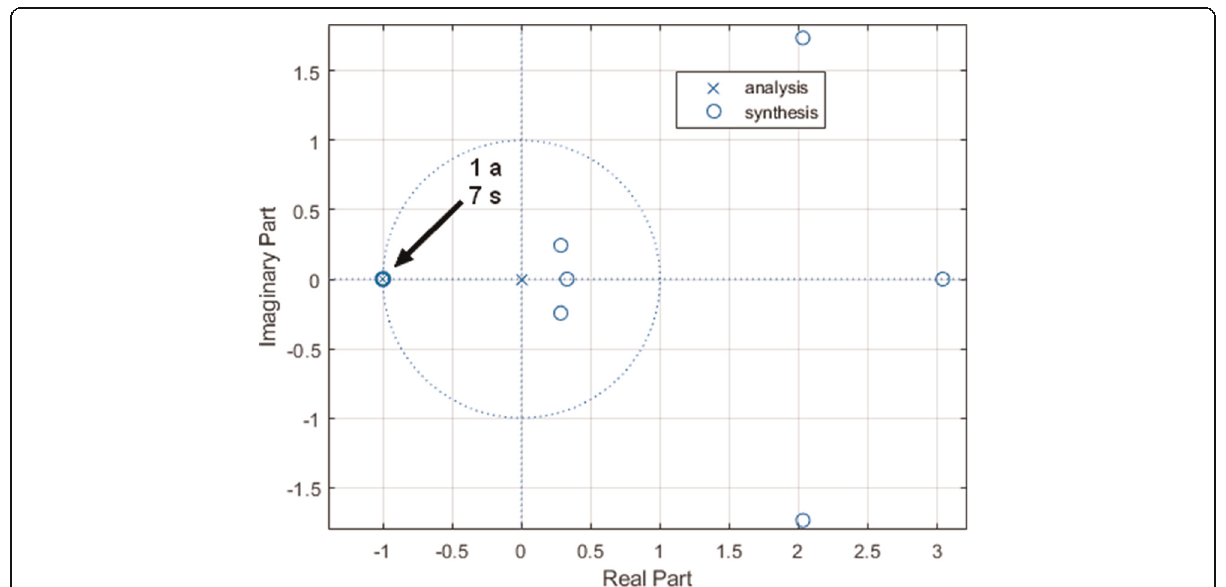
Fig. 5 Roots of designed low-pass filters in analysis and synthesis steps. The multiplicity of roots at z = − 1 for each stage (1 for analysis and 7 for synthesis) is pointed out in the figure